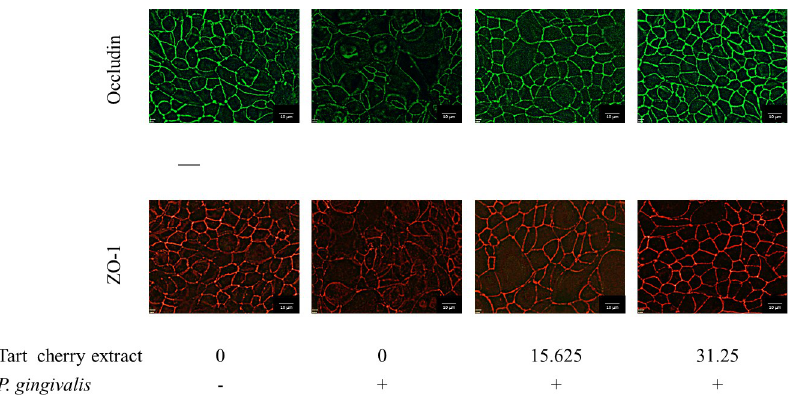
Fig 6. Effect of the tart cherry extract on the immunofluorescence staining of zonula-occludens 1 (ZO-1) and occludin of oral epithelial cell monolayers treated with P . gingivalis (MOI of 10 4 ) for 24 h.